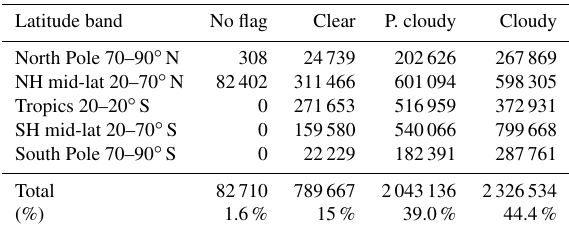
Table 3. Geographical distribution of 5242047 IASI simulations (performed on four days in 2013) according to latitude bands with the corresponding AVHRR cloud mask value (“No flag” states that the cloud mask value is